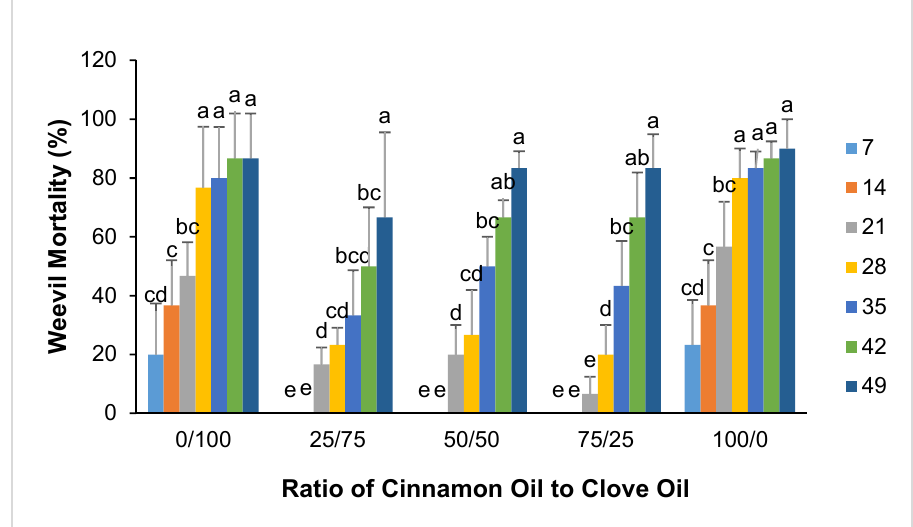
Figure 5. The mortality of maize weevils in organic corn grains at different cinnamon oil to clove oil ratios. Data bars with different labels are significantly different at 5% significance level.